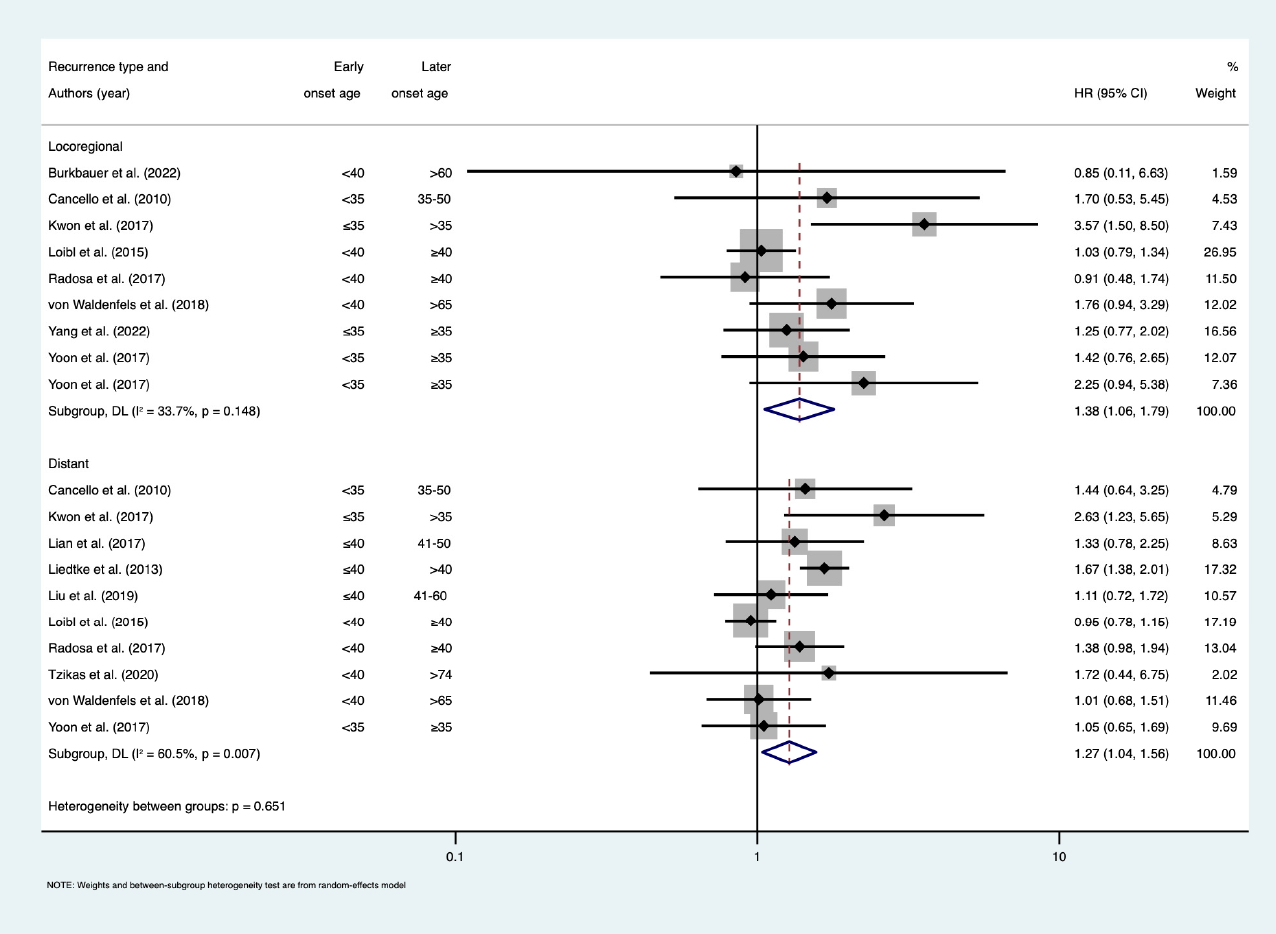
Figure 3. Forest plot for meta-analysis of locoregional and distant recurrence-free survival. Hazard ratios less than 1 show favourable outcomes in early-onset age group; hazard ratios greater than 1 show poorer outcomes in early-onset age group. References [19,20,31,33,34,36–38,42,45,47,49]. Abbreviations: CI = confidence interval; HR = hazard ratio.